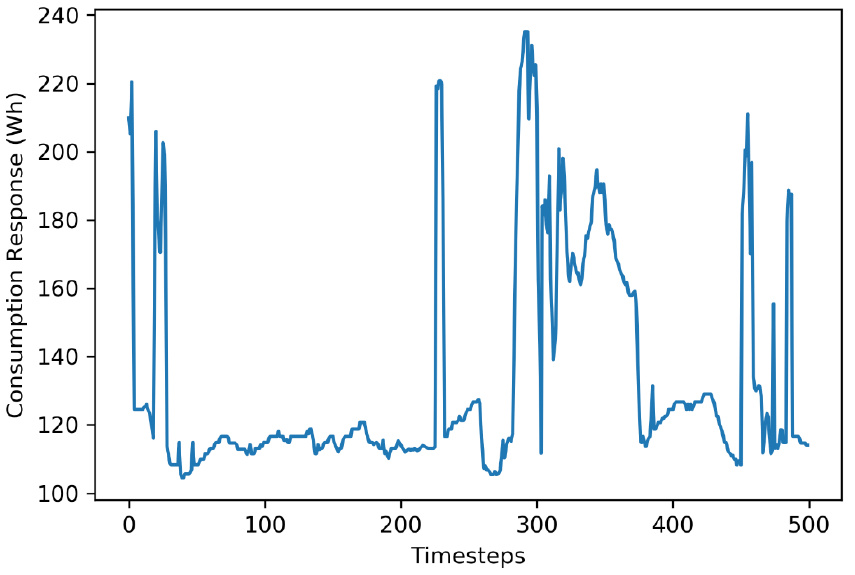
Figure 8. Minimum energy consumption response values for 500 timesteps. Each timestep is a 10-min interval corresponding to a dataset measurement.